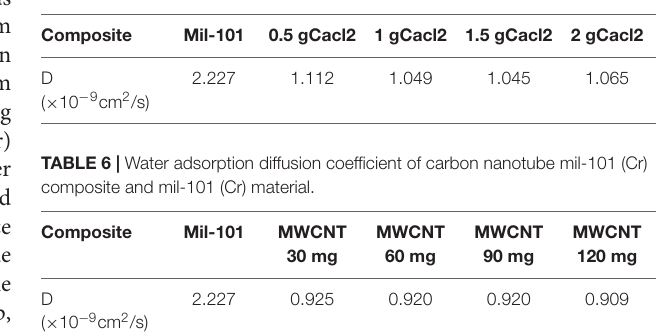
TABLE 5 | Water adsorption diffusion coefficient of calcium chloride mil-101 (Cr) composite and mil-101 (Cr) material.